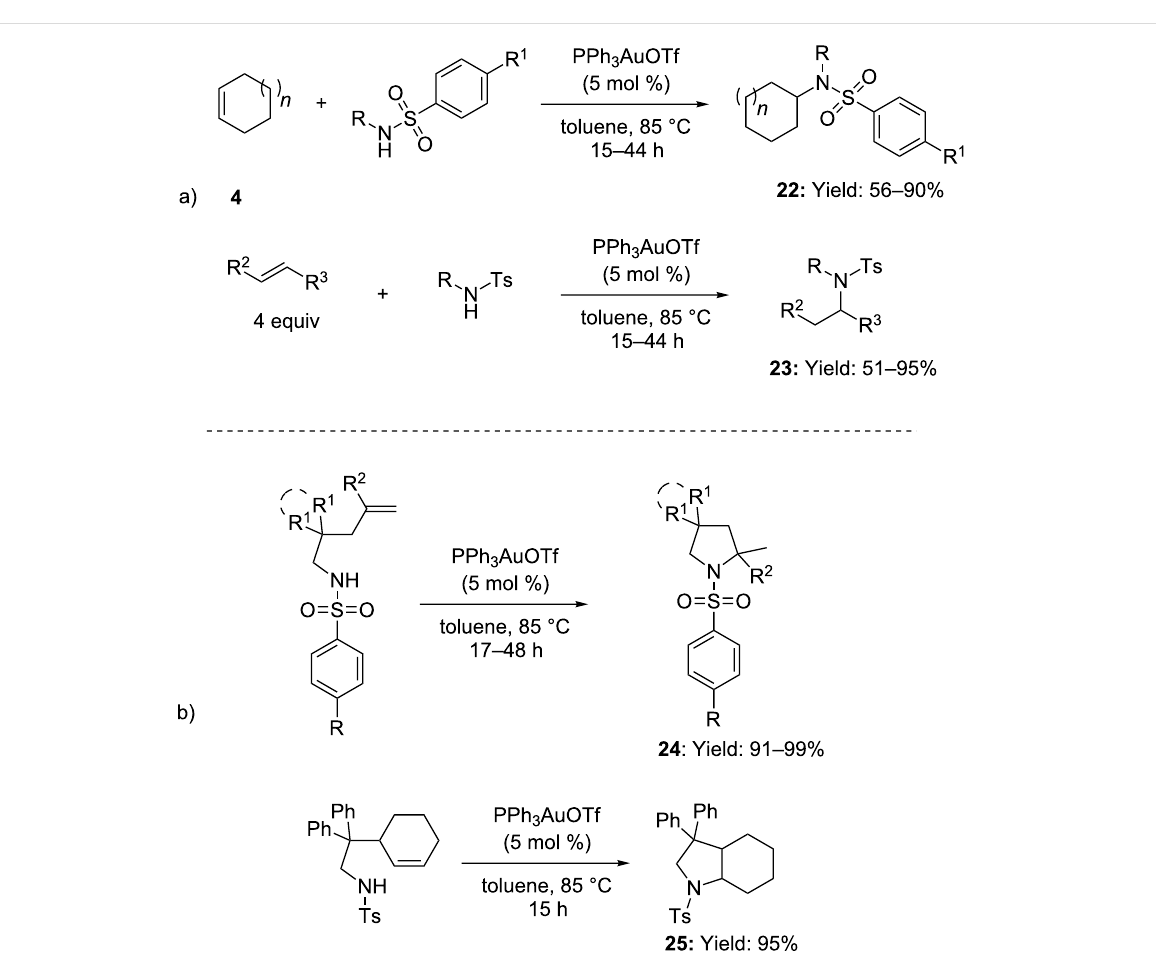
Scheme 8: [Au(I)]-catalyzed inter- as well as intramolecular addition of sulfonamides to isolated